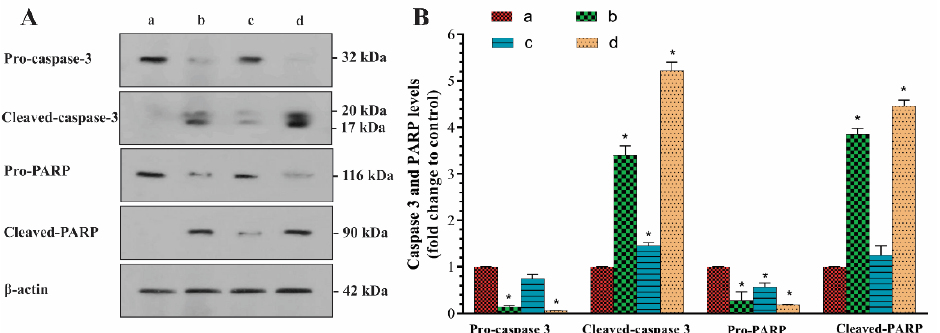
Figure 8. ( A ) Descriptive images of Western blot analysis of caspase-3 and PARP proteins. ( B ) Caspase-3 and PARP protein levels (fold change to control) in A549 cells treated with IC 50 concentration of Pinus eldarica extracts and essential oil for 48 h. a. Control group, b. pollen hexane extract-treated group (31.7 µg/mL), c. bark essential oil-treated group (17.9 µg/mL), and d. methanolic needle extract-treated group (0.3 µg/mL). PARP, poly (ADP) ribose polymerase. Data are expressed as mean ± standard deviation (SD), representative of three independent experiments. * p < 0.05 vs. control.